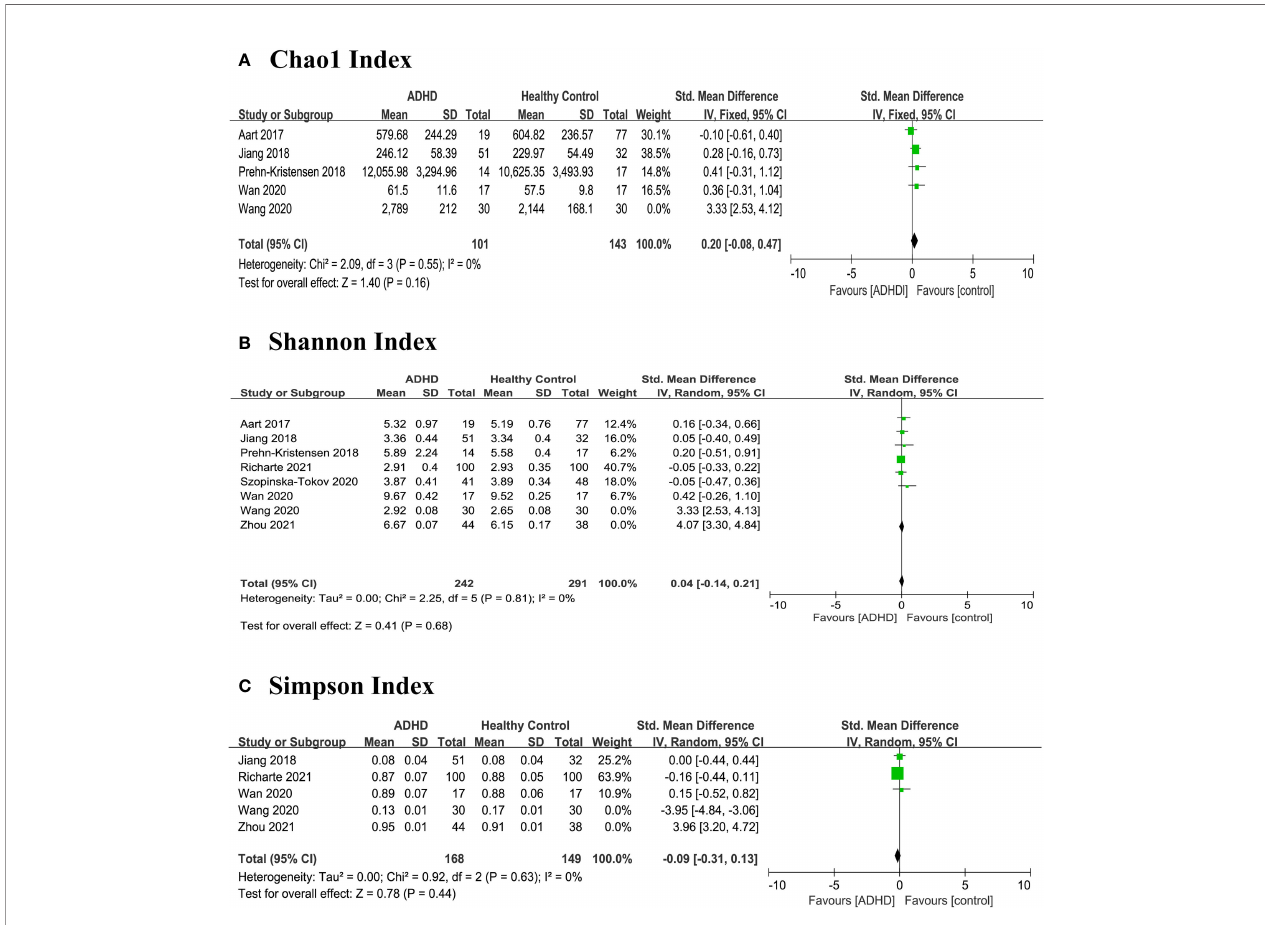
FIGURE 4 | Sensitivity analysis of alpha diversity in the gut microbiota of ADHD compared with HCs after removing heterogeneous studies of Wang 2020 and Zhou 2021 (17). (A) Chao1 index; (B) Shannon index; (C) Simpson index. CI, con fi dence interval; SMD, standardized mean